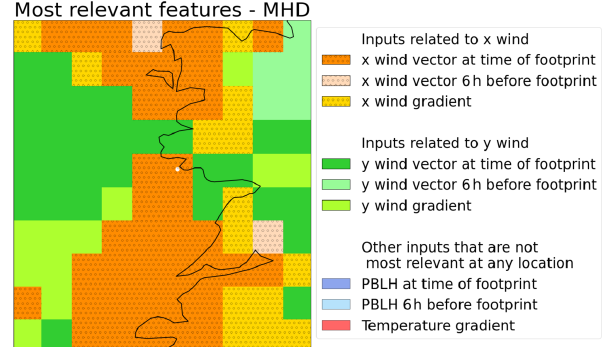
Figure 8. Most important block of meteorological features at each cell for Mace Head, as calculated with the block permutation im-